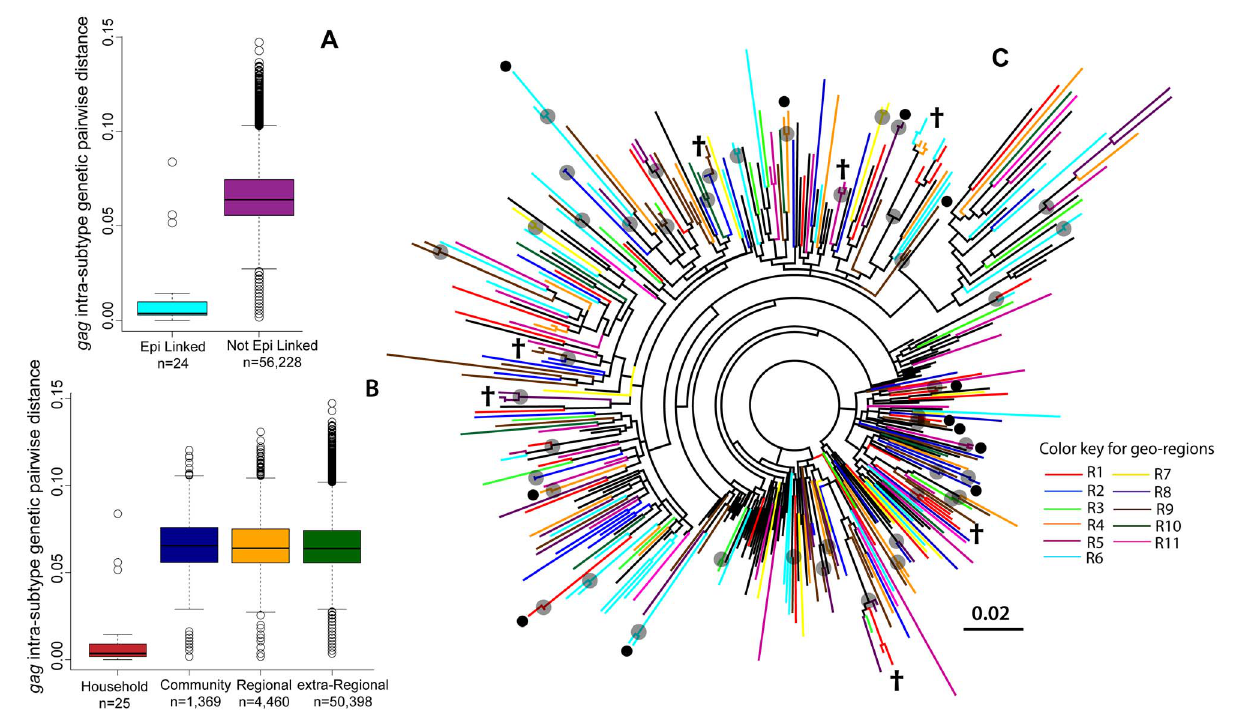
Figure 3. Maximum likelihood phylogenetic analyses of the HIV-1 gag gene. (A) Boxplots of the intra-subtype gag genetic pairwise distances for epidemiologically linked (Epi linked) incident couples (i.e., at least one member of the couple was an incident case) and for all epidemiologically unlinked incident pairs of individuals in RCCS R13. (B) Boxplots of intra-subtype gag genetic pairwise distances by the geographic distance between the incident pair. (C) A ML phylogenetic tree (radial) of HIV-1 subtype A gag sequences from HIV-seroprevalent ( n =245) and HIV- incident ( n =55) cases, where taxa are colored by the geographic region from which they were isolated. Reference strains ( n =87) are in black. Grey circles indicate nodes with bootstrap support of $ 70%; black circles indicate intra-household clusters; { indicates an intra-household virus also sharing a cluster with at least one other household. Additional radial and rectangular phylogenetic trees for HIV-1 subtypes A, D, and C for gag and env genes are included in Figures S5, S6, S7, S8, S9, S10, S11, S12,